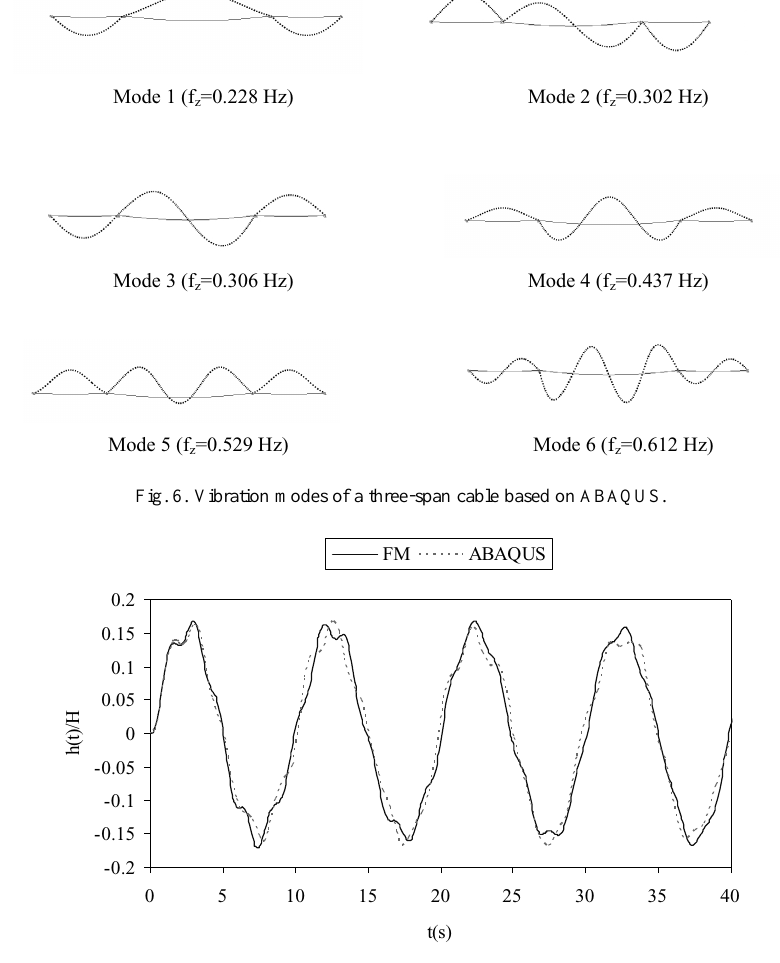
Fig. 7. Dynamic response h ( t ) of a three-span cable ( f = 0.1H z ,q 0 = 0.1 H / l ) .